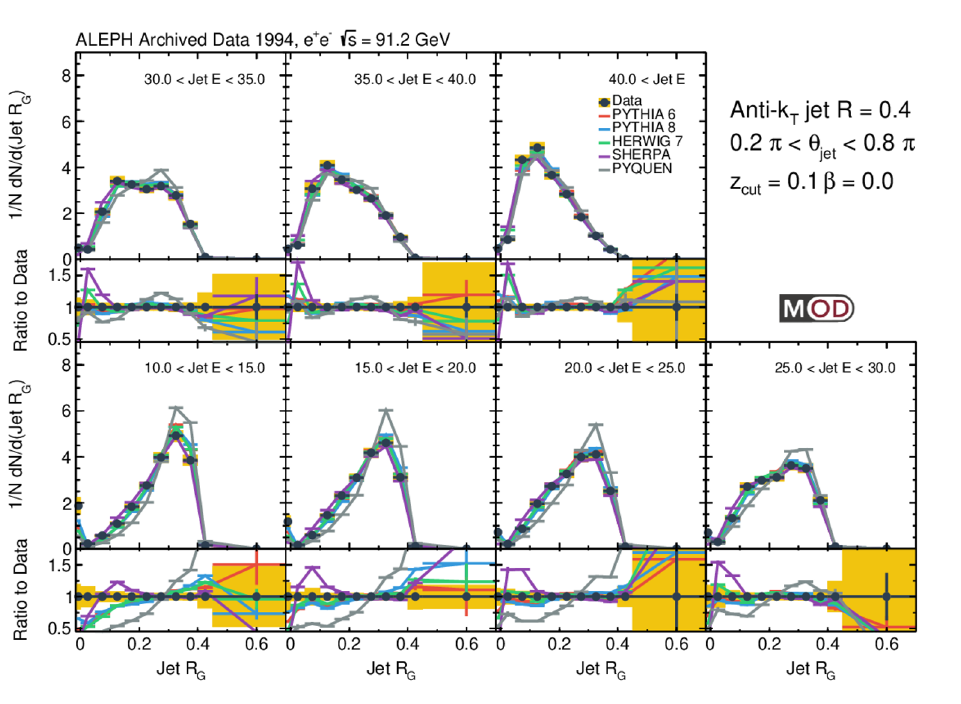
Figure 16 . Measured R G spectra in bins of jet E . The spectrum is self-normalized for each E interval. The fraction of jets completely groomed away are included in the first bin of each panel. The data is also compared with predictions from Pythia 6 (red), Pythia 8 (blue), Herwig (green), and Sherpa (purple)